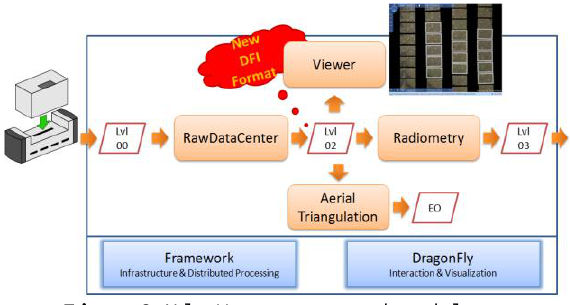
Figure 2. UltraMap concept and modules.